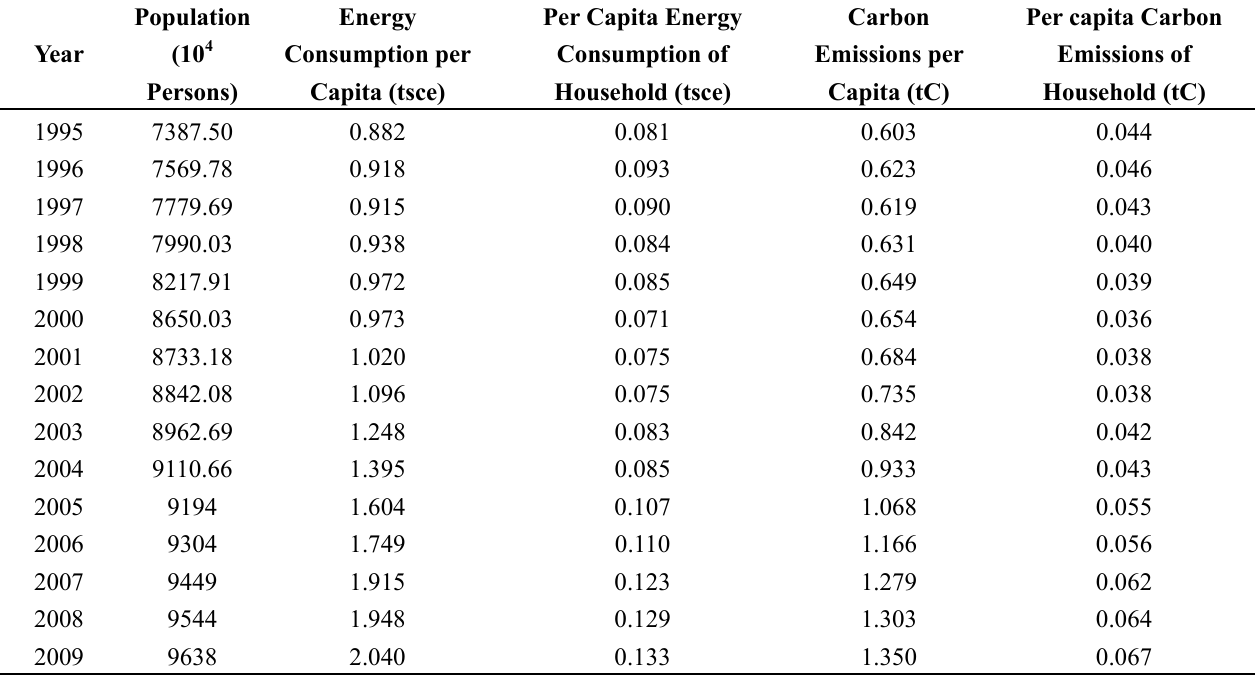
Table A6. Energy consumption and carbon emissions per